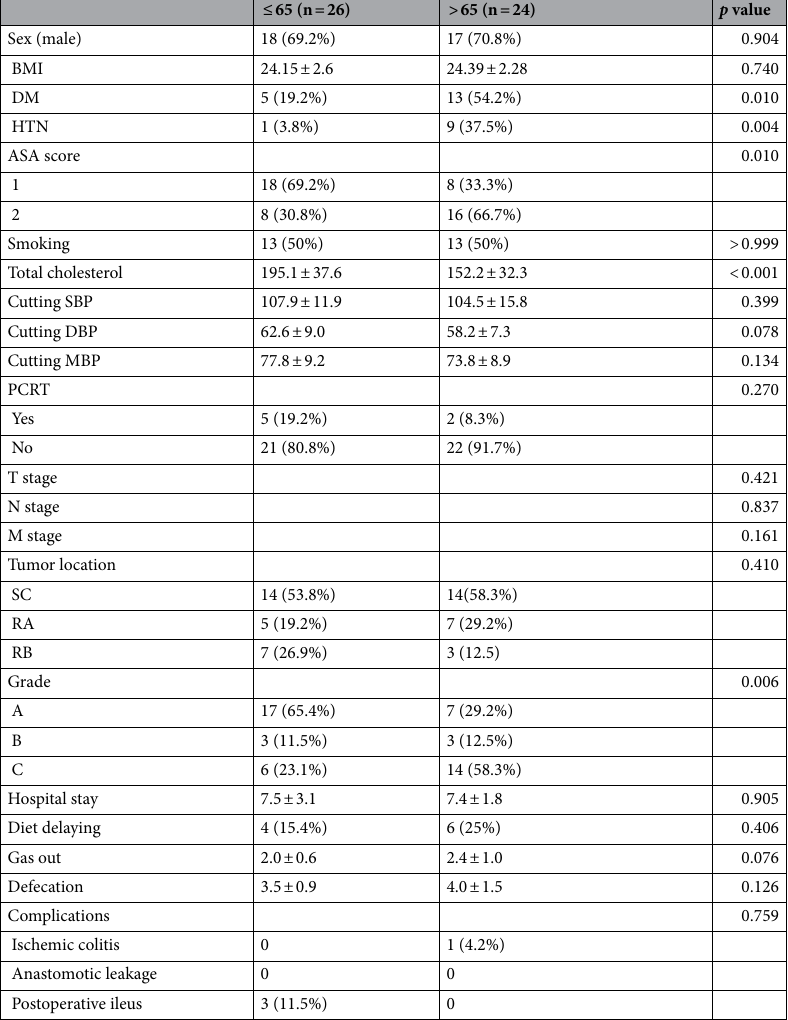
Table 7. Clinicopathological characteristics, distribution of perfusion grade and postoperative outcomes according to age. BMI body mass index, HTN hypertension, DM diabetes mellitus, SBP systolic blood